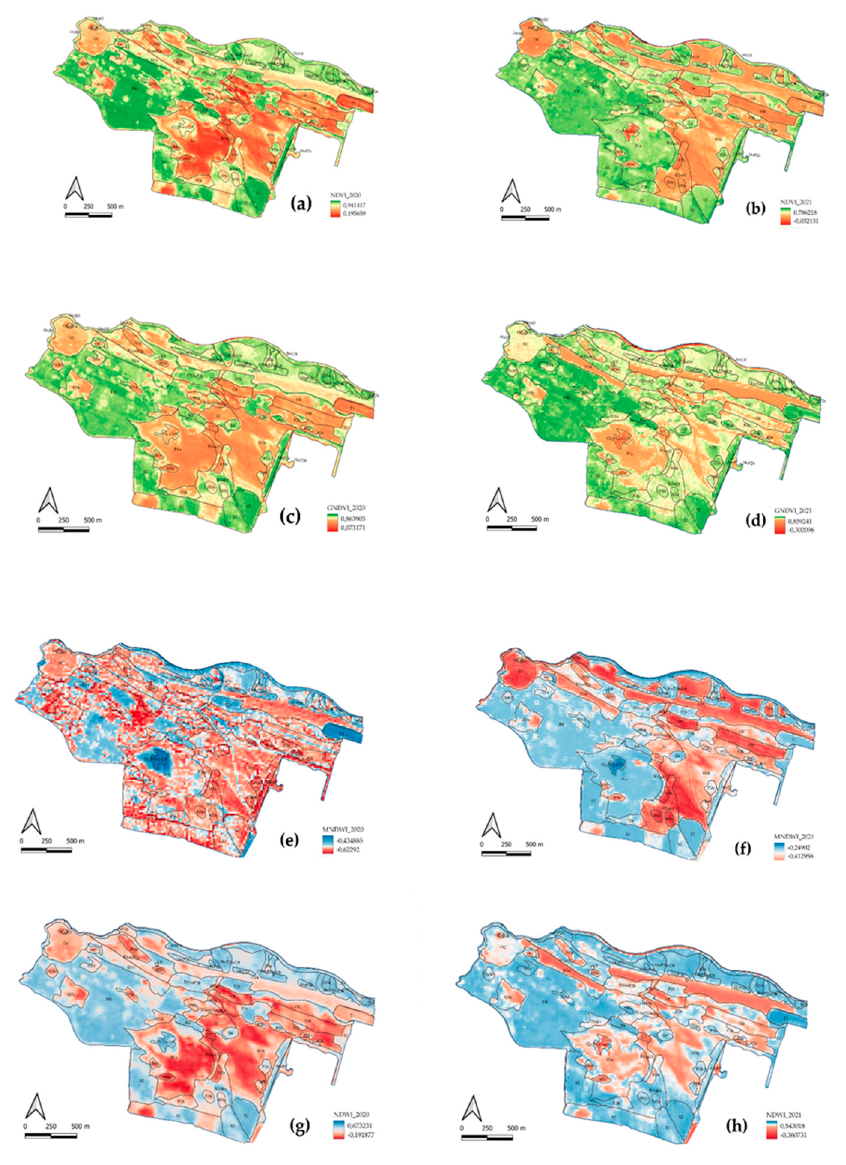
Figure 4. 2020 and 2021 habitat map with coloring based on the selected values—( a ) NDVI _2020, ( b ) GNDVI _2020, ( c ) NDWI _2020, ( d ) MNDWI _2020, ( e ) NDVI _2021, ( f ) GNDVI _2021, ( g ) NDWI _2021, and ( h ) MNDWI _2021.